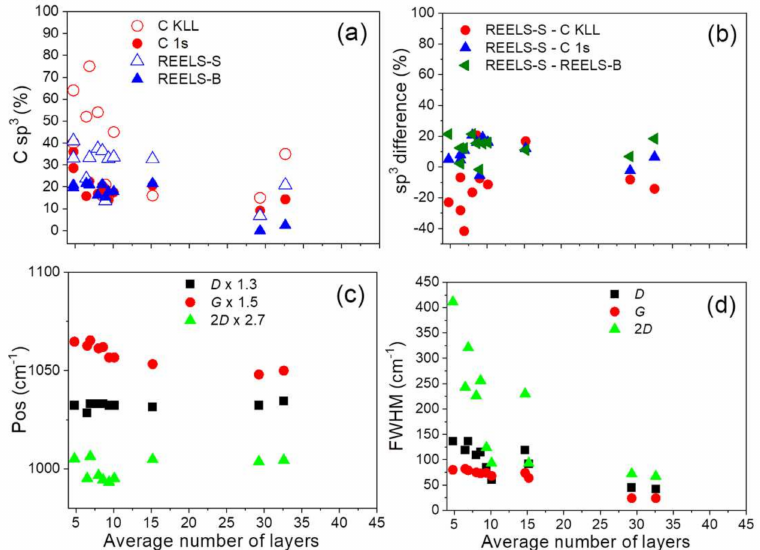
Figure 9. ( a ) C sp 3 content determined from C KLL AES spectra and parameter D (Table 4), C 1s spectra fitting (Table S2) and REELS-surface (REELS-S) and REELS-bulk (REELS-bulk) components (Table 3), ( b ) the respective differences, Raman spectra D , G , 2 D modes ( c ) positions (Table 2) and ( d ) FWHMs (Table 2) dependent on the average number of layers in the investigated